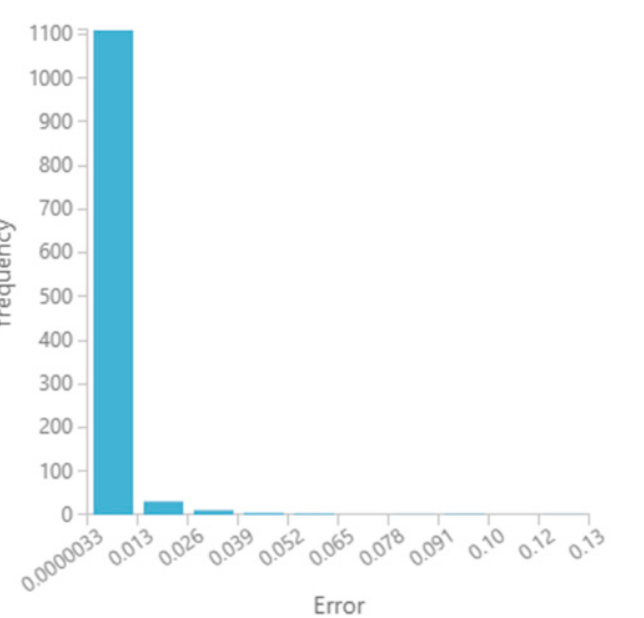
Figure 7. Error histogram of the predicted values of the dc/dt by using the two operating parameters of total oxygen flow and lance height in the pilot plant dataset.